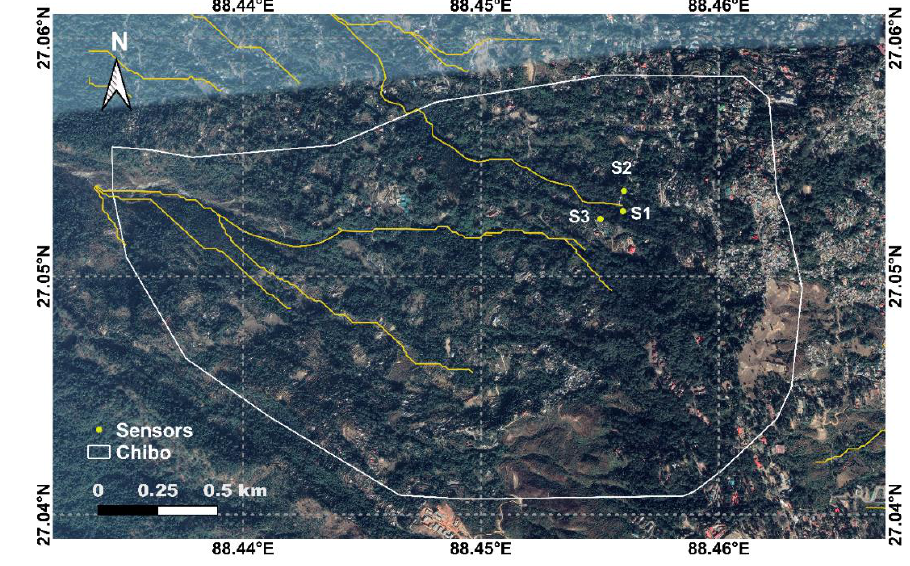
Figure 6. Location of sensors in Chibo, Kalimpong.